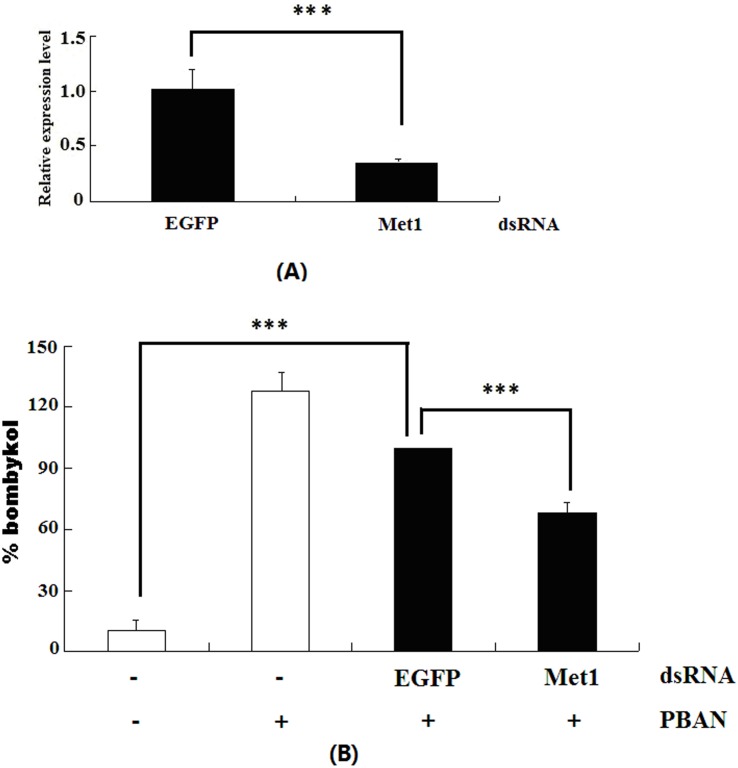
Effects of RNAi treatment on bombykol production.A: RNAi-induced reduction of Met1 gene. qPCR was carried out using cDNA generated from the total RNA extracted from PGs of females injected with 20 µg dsRNAs for Met1 and EGFP (Control). B: Effects of RNAi for Met1 on bombykol production. The females 48 h prior to eclosion were injected with double stranded RNAs, after 48 h waiting time, the females injected with dsRNA were decapitated and then were further injected with 10 pmol PBAN 24 h after decapitation. Bombykol production was measured by GC/MS from PGs 90 min after injection of PBAN. Bars indicate the mean values ± S.D. for independent experimental animals (n> = 12). Statistically significant differences from the PBAN alone are denoted by *** (p<0.01) as determined by the Student’s t-test.